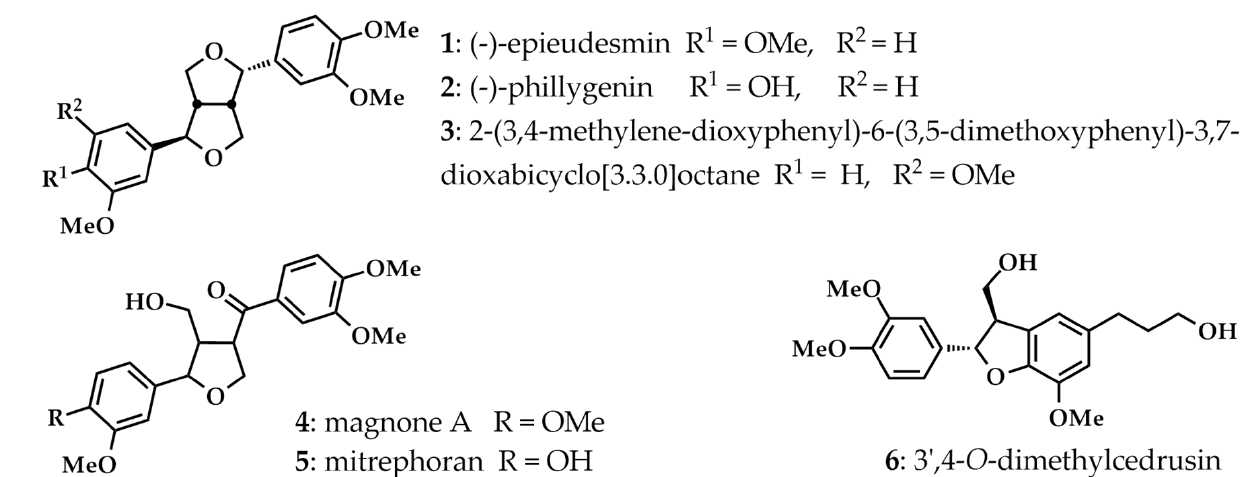
Figure 1. Isolated lignans 1 – 6 from the methanol extract of M. sirikitiae leaves. After treatment of the cells with various concentrations of the samples for 24 h, the number of viable cells was measured and calculated as the percentage of viable cells compared to a nontreated (control) group. As shown in Figure 2, the MTT results revealed that the number of survival cells more than 80% were found in the groups treated with 0.05–10 µ g/mL of the methanol extract, lignans 1 , 2 , or 6 , and 0.05–5 µ g/mL of lignans 3 , 4 , or 5 . In order to avoid the cytotoxic effect and allow at least 80% cell viability, the